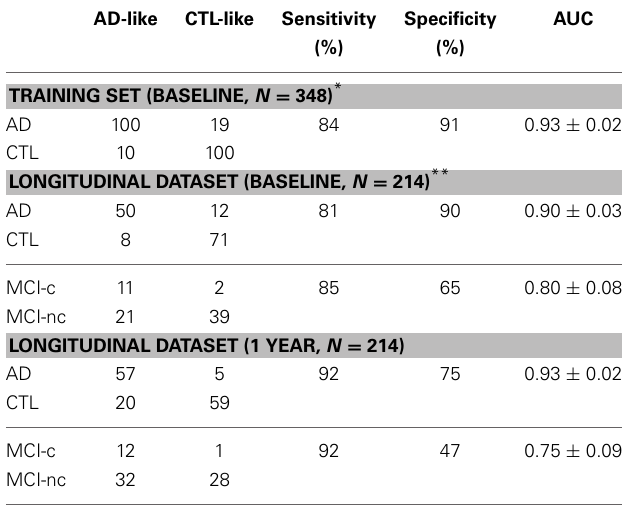
Table 5 | Performance and prediction based on the AD vs. CTL classification